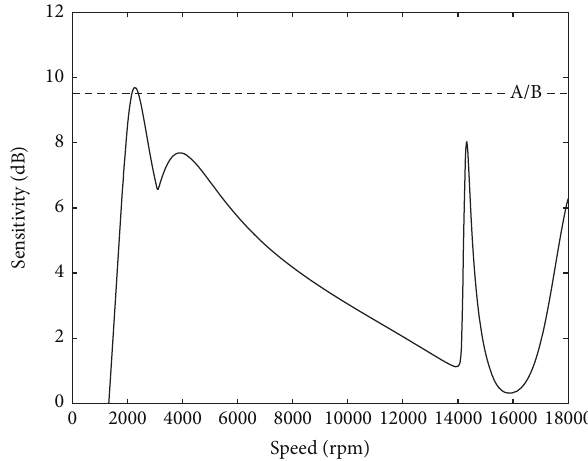
Figure 6: Output sensitivity of the reference controller.